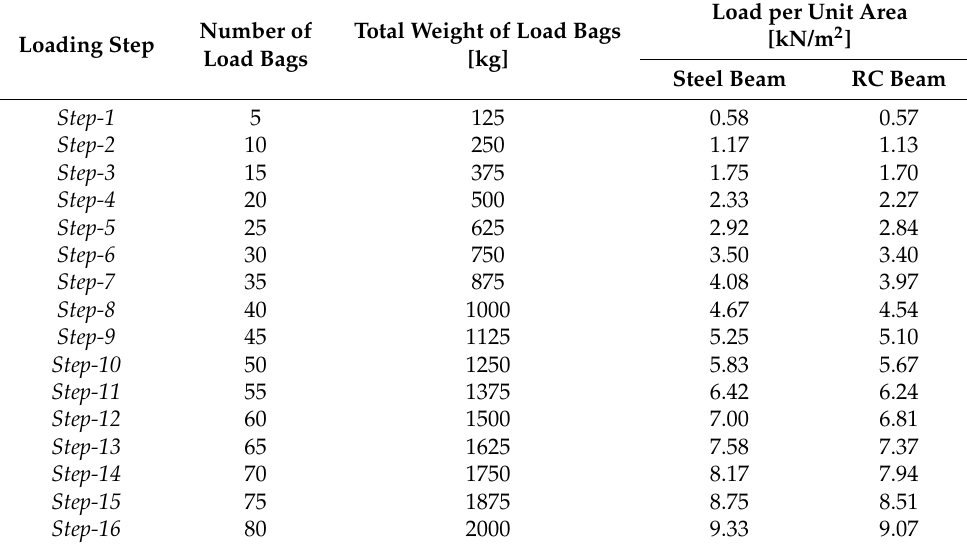
Figure 5. Locations of LVDTs.